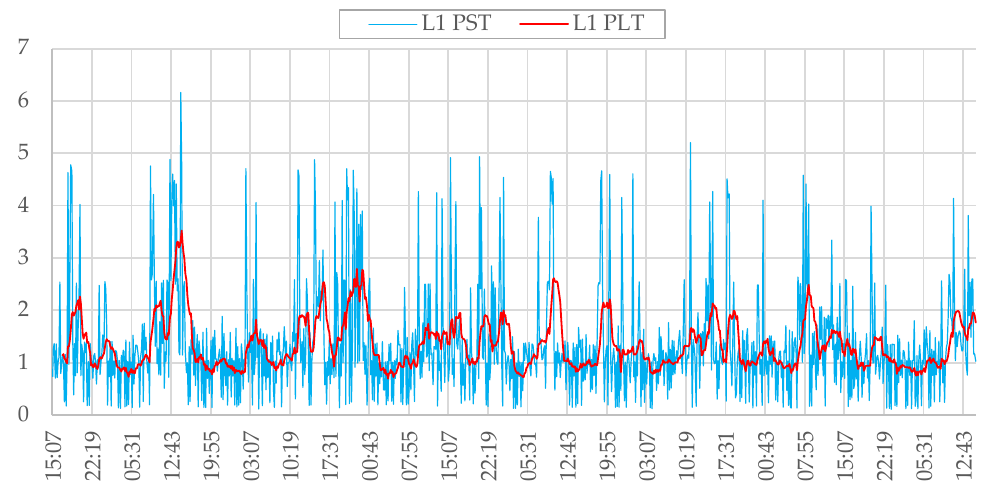
Figure 15. Flicker values for Object 3 in phase L1, according to standard EN 50160–PST in 10-min intervals and PLT in 2-h average intervals (allowed limit <1.0 95% of the time).